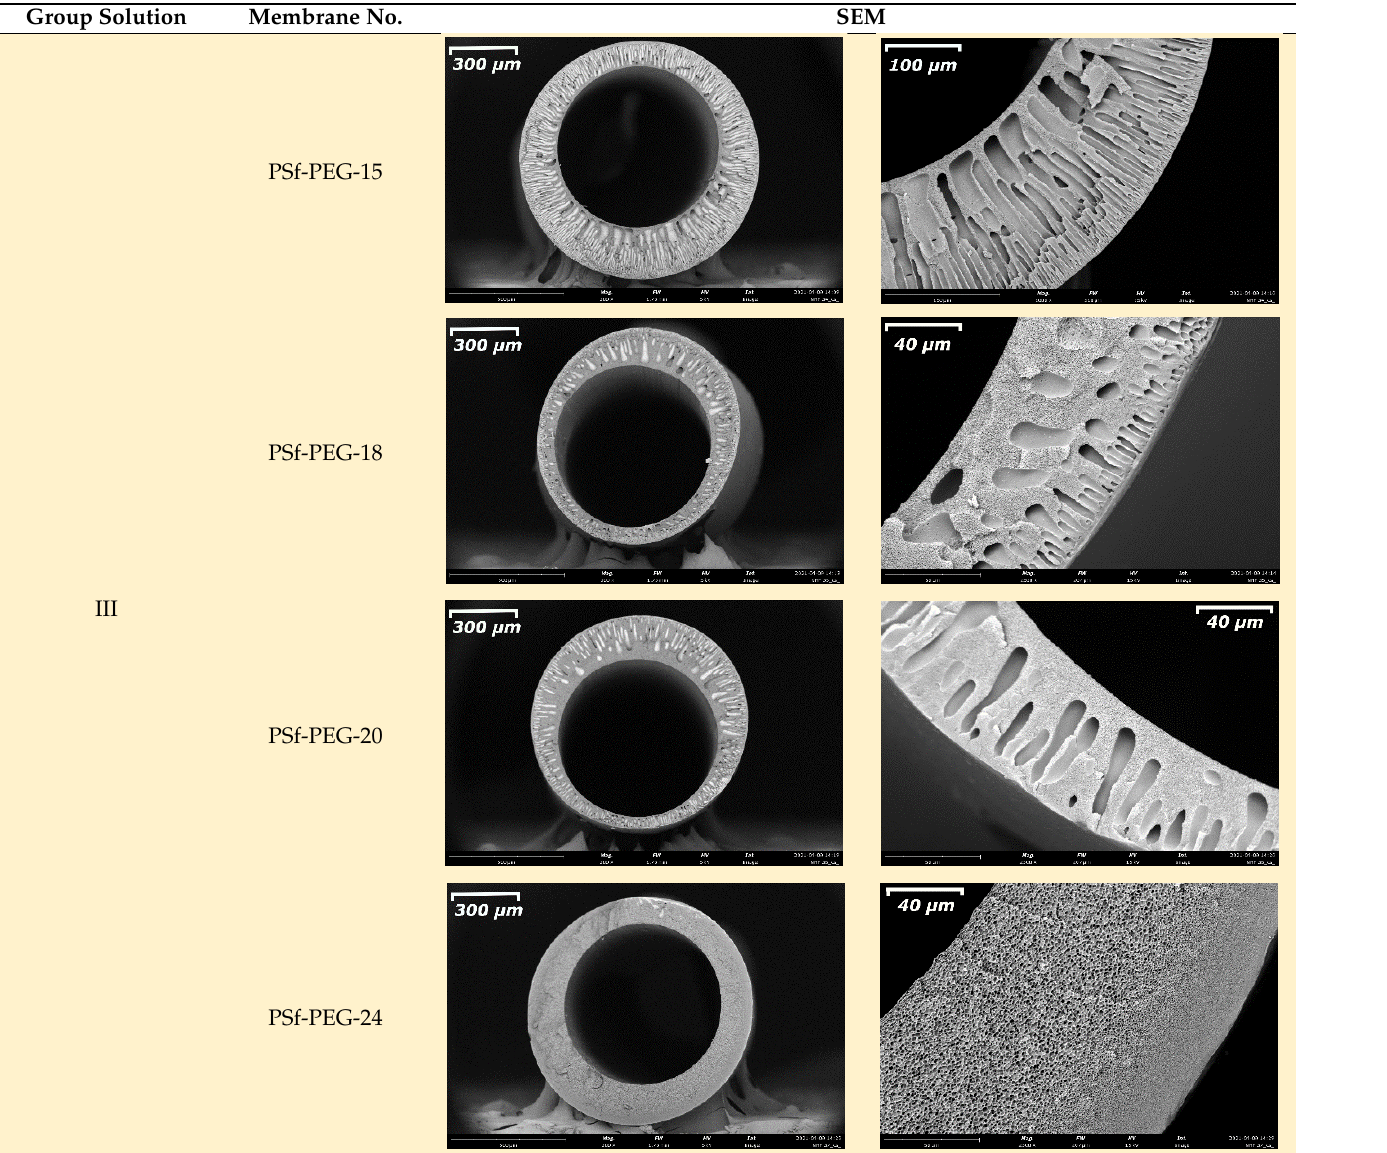
Table 5. Solubility parameters of the pore-forming agents, solvent, and coagulant.